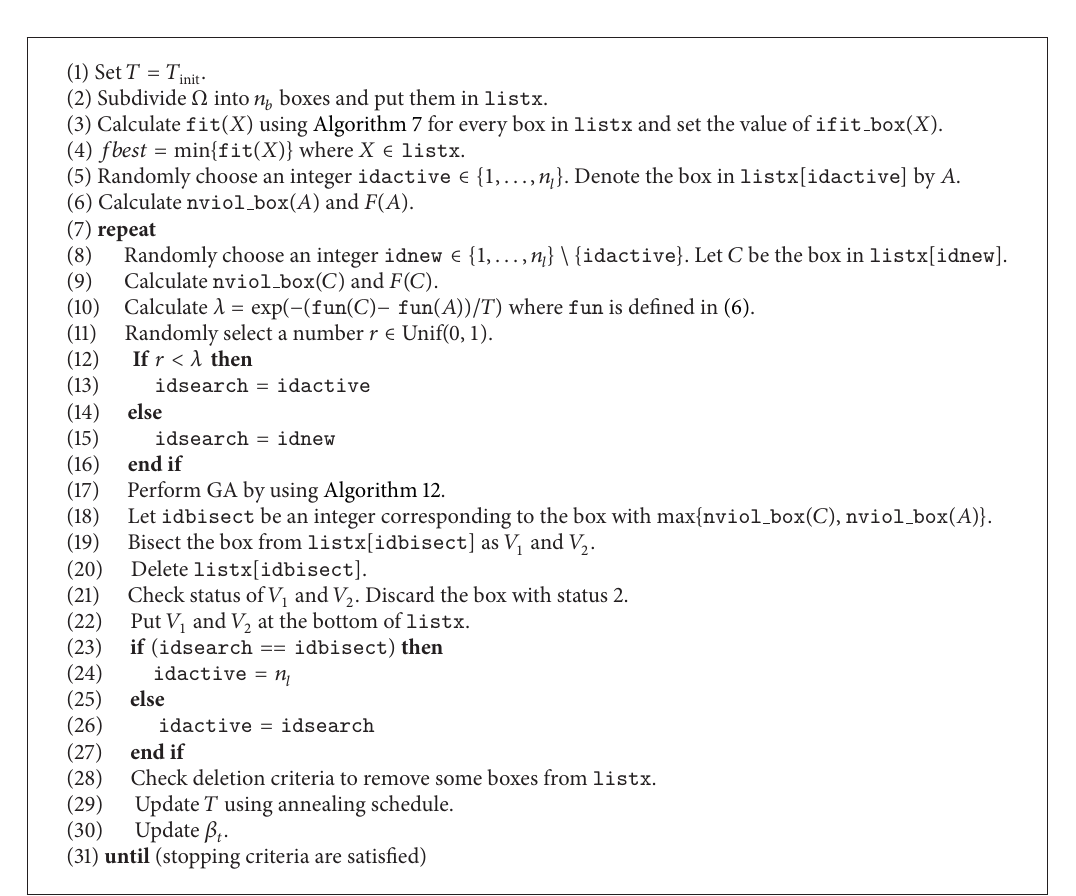
Algorithm 11: Integrated interval algorithm and GA for constrained problems.